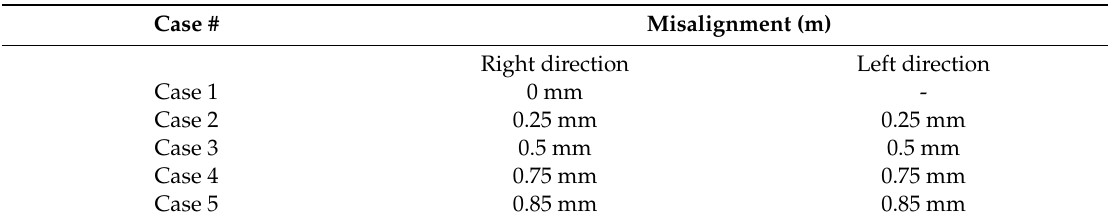
Table 2. Five Simulated misalignment cases. Misalignment is measured as the center-to-center distance along the x